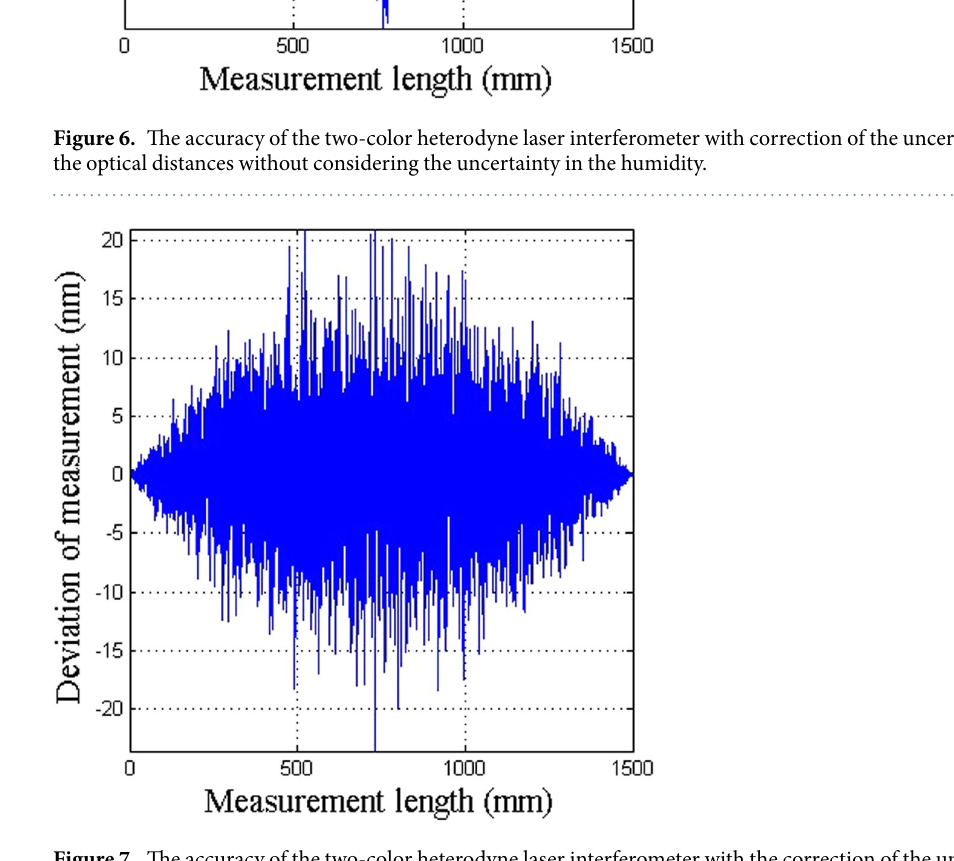
Figure 7. The accuracy of the two-color heterodyne laser interferometer with the correction of the uncertainty in the optical distances with consideration of the uncertainty in the